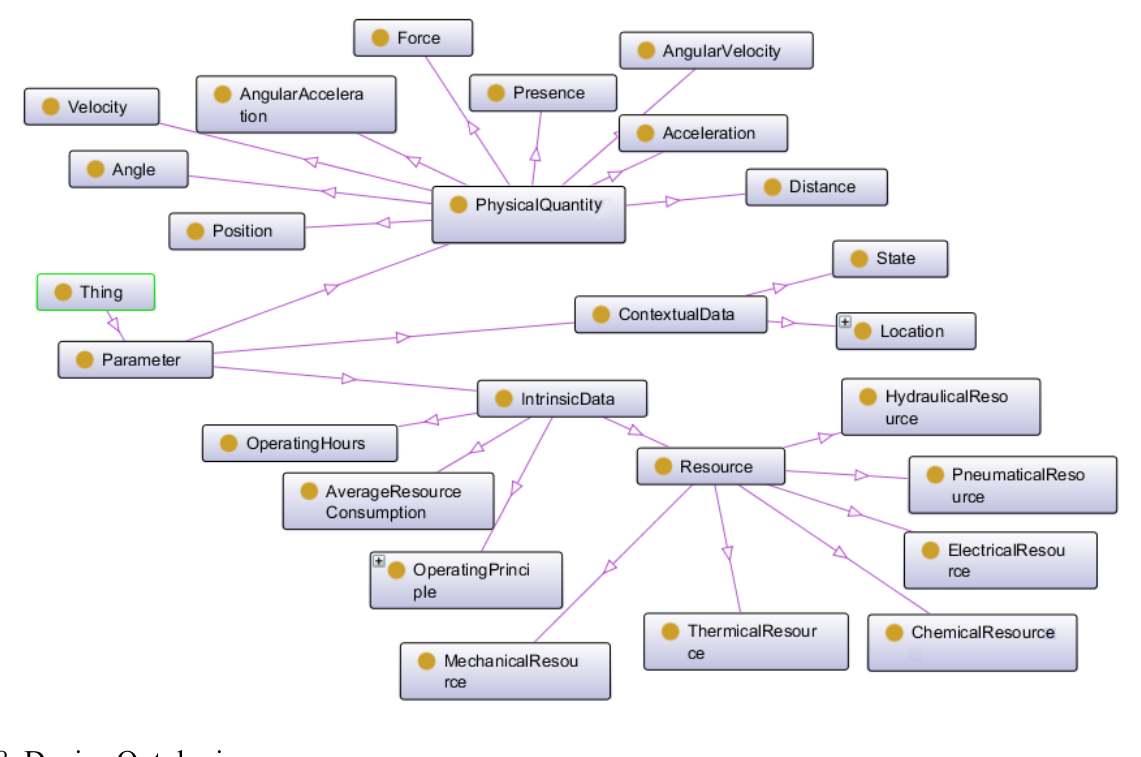
Figure 4. Part of the parameter